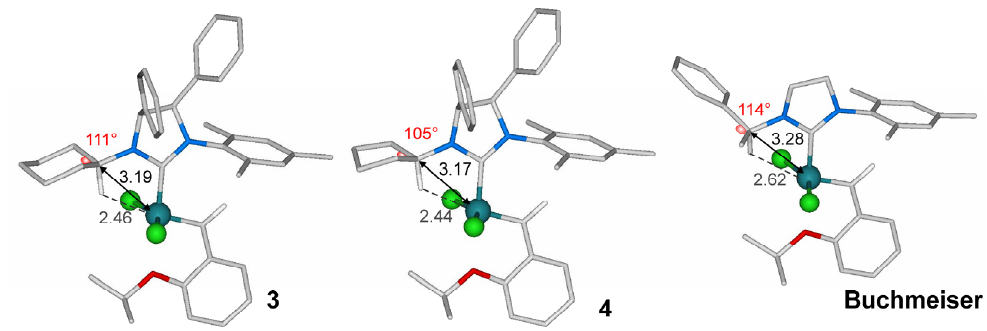
Figure 7. Minimum energy structures of catalysts 3 [45] and 4, as well as the Buchmeiser catalyst. Most hydrogens were omitted for clarity. Distances are in Å.